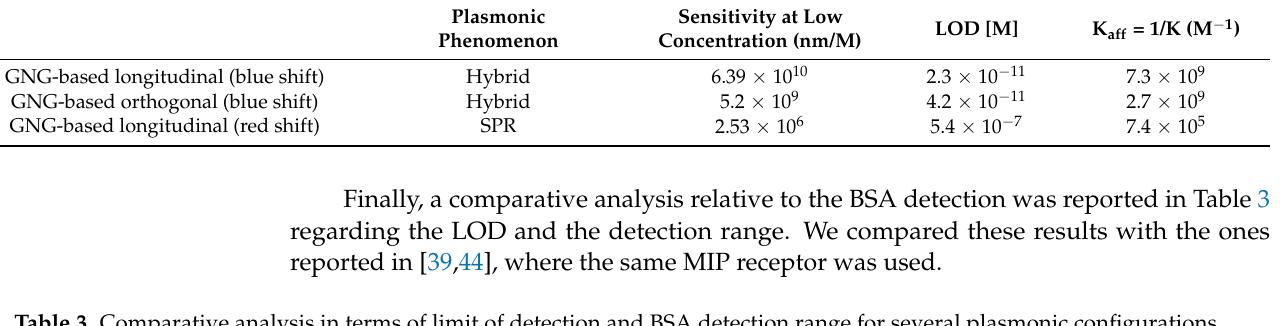
Table 3. Comparative analysis in terms of limit of detection and BSA detection range for several plasmonic configurations combined with the same MIP